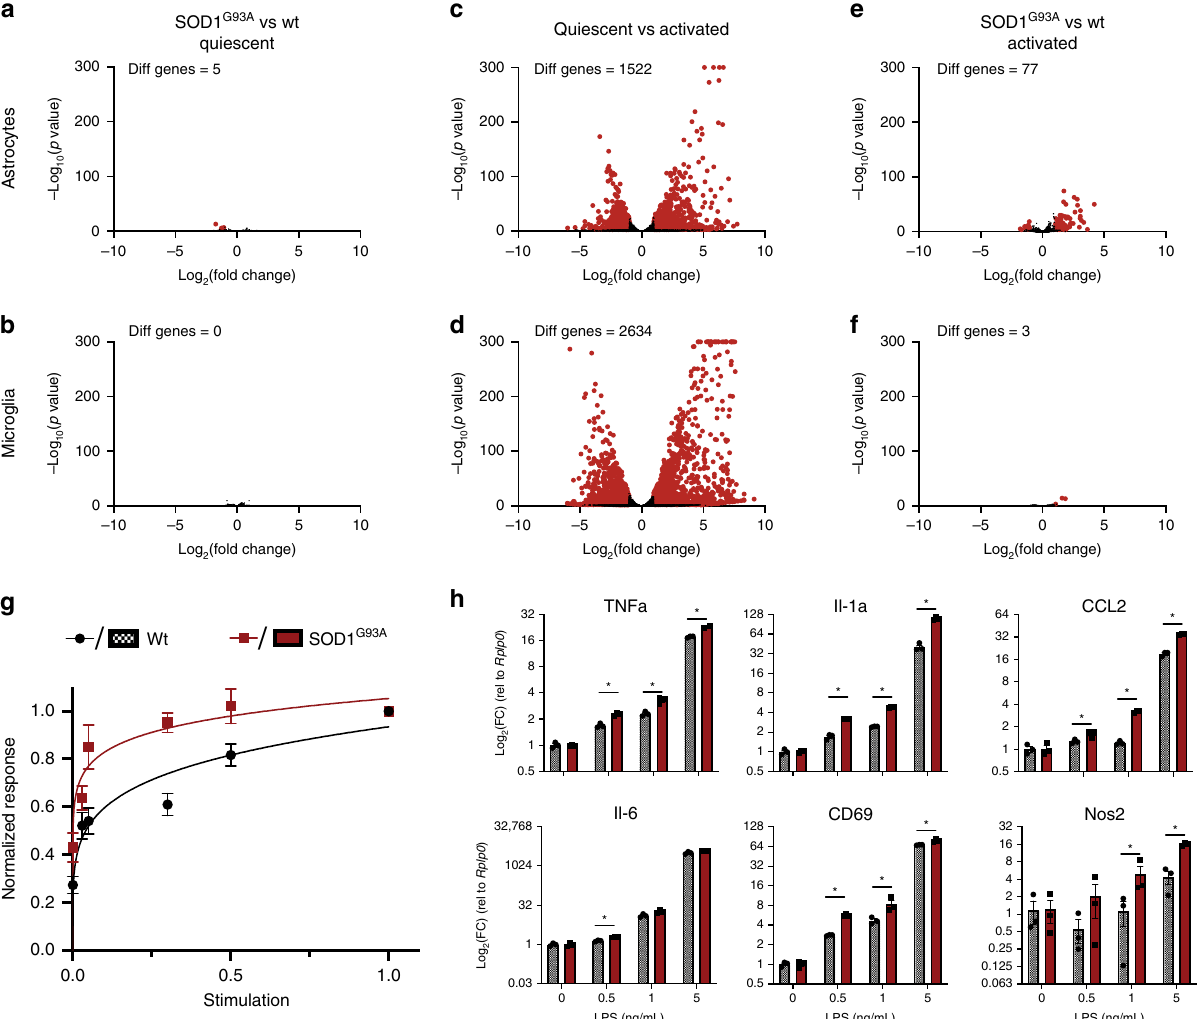
Fig. 2 SOD1 G93A and WT glia are cell-autonomously similar when quiescent. a – f Bulk RNA-seq of immunopanned astrocytes and Cd11b MACs puri fi ed microglia from WT and SOD1 G93A mice cultured in serum-free conditions. (Red dot indicates signi fi cant change with adjusted p value < 0.001 and |log 2 (fold change)| > 1) a , b SOD1 G93A and WT astrocytes and microglia are transcriptomically similar when quiescent in serum-free conditions. c , d Astrocytes activated by IL-1 α (3 ng/mL), TNF α (30 ng/mL), and C1q (400 ng/mL) and microglia activated by LPS (50 ng/mL) change dramatically at the transcriptome level, highlighting the transcriptomic sensitivity of these cells. e Fully activated SOD1 G93A and WT astrocytes are largely transcriptomically similar, but show some expression differences associated with cytokine and immune activation. f Fully activated SOD1 G93A and WT microglia are transcriptomically similar. g Normalized response kinetics of 40 astrocyte reactive marker genes assessed by micro fl uidics qPCR in response to submaximal doses of IL-1 α , TNF α , and C1q. SOD1 G93A astrocytes show larger reactivity responses to smaller insults than WT astrocytes. (error bars represent ± s.e.m.; curves represent nonlinear normalized response curves) h Expression of selected microglial activation genes assessed by qPCR in response to submaximal doses of LPS. SOD1 G93A microglia show a slight but signi fi cant increase in activation to smaller insults compared to WT microglia. (* p < 0.05 by unpaired, two-tailed Student ’ s t test; Holm – Sidak correction; mean ±